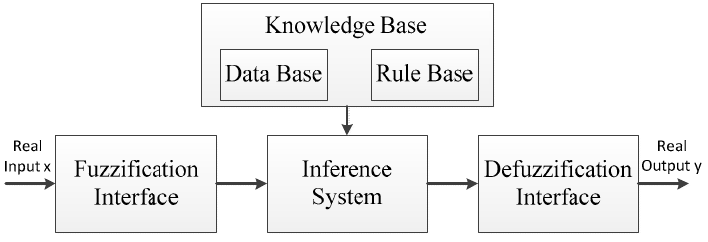
Figure 1. Fuzzy logic system which is composed of fuzzification interface, inference system, knowledge base and defuzzification interface.